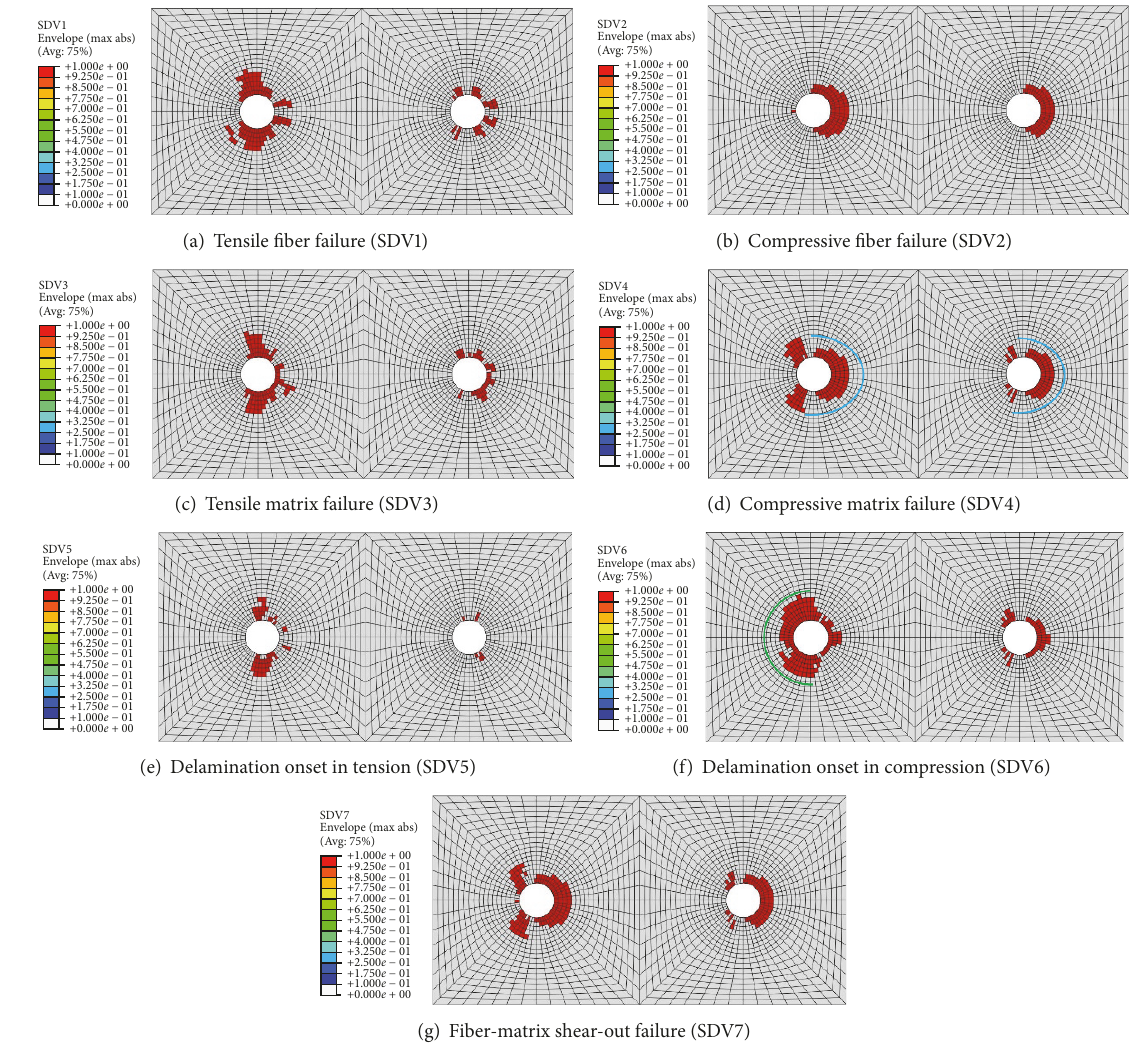
Figure 8: Damage envelope of various failure modes under ultimate